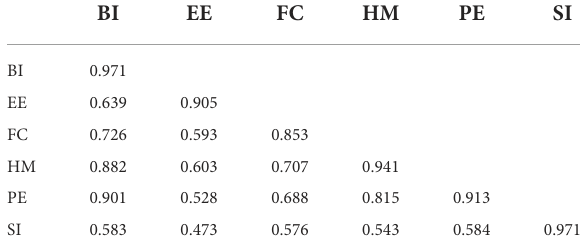
TABLE 4 Factors loadings and cross-loadings.